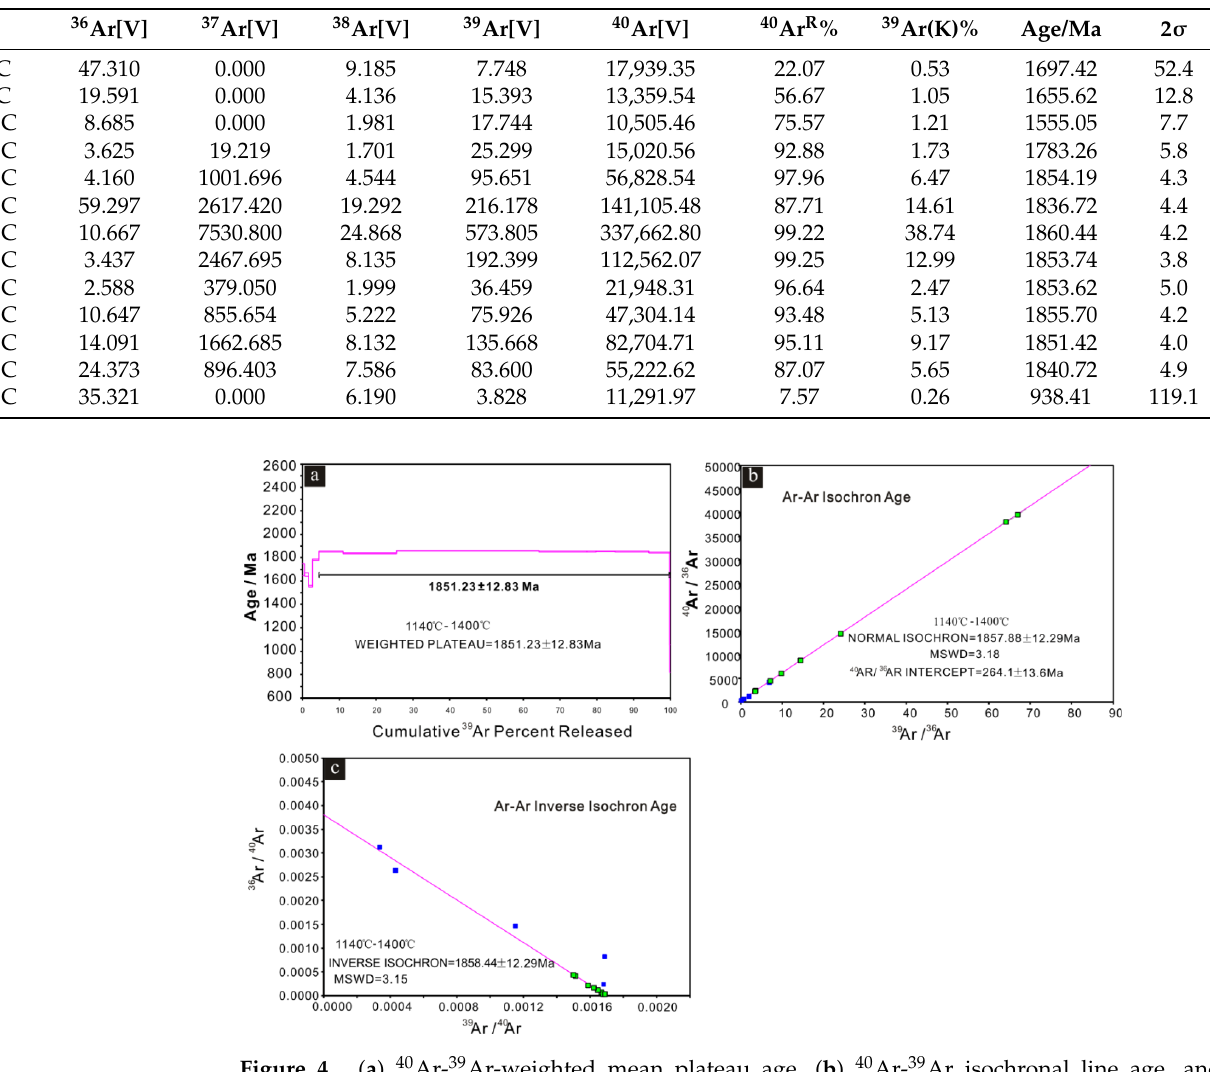
Figure 4. ( a ) 40 Ar − 39 Ar-weighted mean plateau age, ( b ) 40 Ar − 39 Ar isochronal line age, and ( c ) 40 Ar − 39 Ar inverse isochronal line age of tremolite samples.